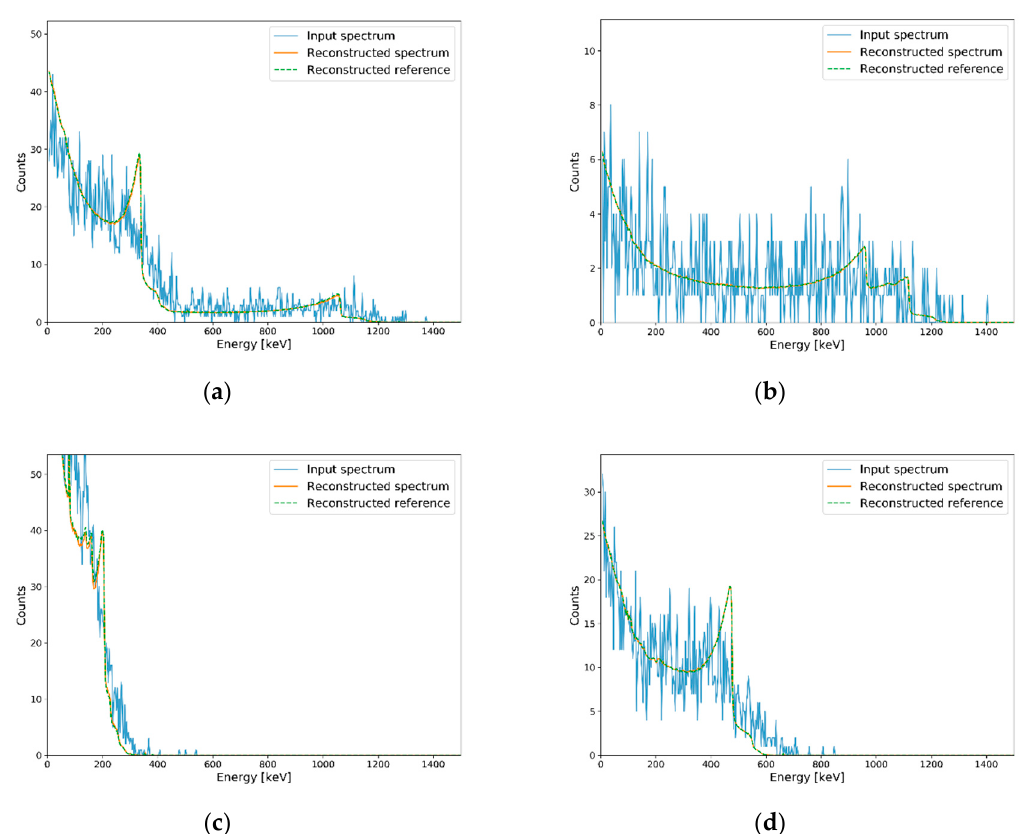
Figure 10. Examples of generated spectra for single isotope corresponding to each MRC and their Compton edge reconstruction results. Reconstruction results on ( a ) generated spectrum for 22 Na, ( b ) generated spectrum for 60 Co, ( c ) generated spectrum for 133 Ba, and ( d ) generated spectrum for 137 Cs. Table 2. Determined minimum reconstructible counts (MRCs) where averaged MAPEs are lower than 10% for each isotope.